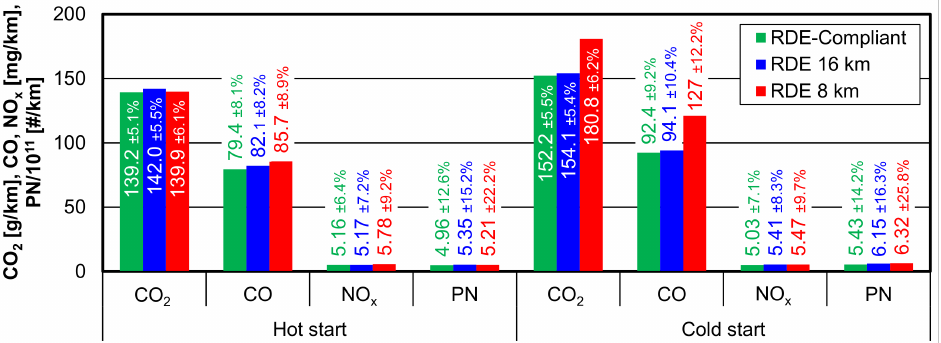
Figure 7. Road emission values (including standard deviation) for cold and hot start for tests RDE-Compliant, RDE 16 km and RDE 8